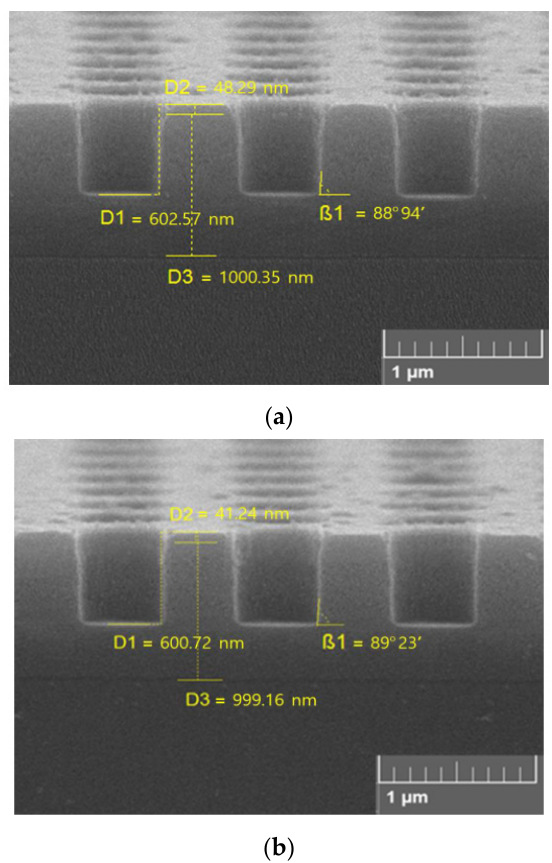
Figure 6. Etched profiles for 45% CF 4 + 45% C 4 F 8 + 10% O 2 ( a ) and 45% CF 4 + 45% CF 2 Br 2 + 10% O 2 ( b ) plasmas. Plasma parameters correspond to Figure 1.